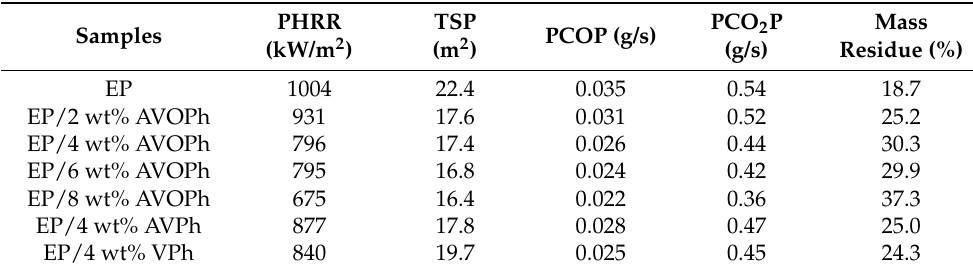
Figure 4. CCT curves of pure EP and its composites: ( a ) HRR curves; ( b ) TSP curves; ( c ) COP curves; ( d ) CO 2 P curves. Table 3. CCT data of pure EP and EP